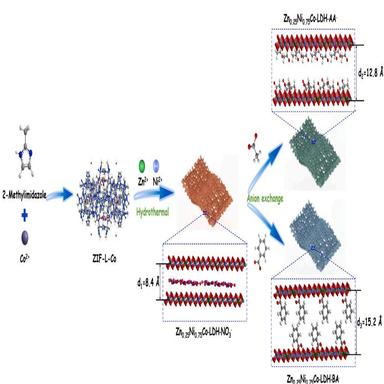
SEM images of the (a-c) Zn0.25Ni0.75Co-LDH-BA– , (d) Zn0.25Ni0.75Co-LDH-AA– , (e) Zn0.25Ni0.75Co-LDH-NO3 – , (f) Zn0.5Ni0.5Co-LDH-NO3 – , (g) Zn0.75Ni0.25Co-LDH-NO3 – , (h) NiCo-LDH-NO3 – , and (i) ZnCo-LDH-NO3 – .